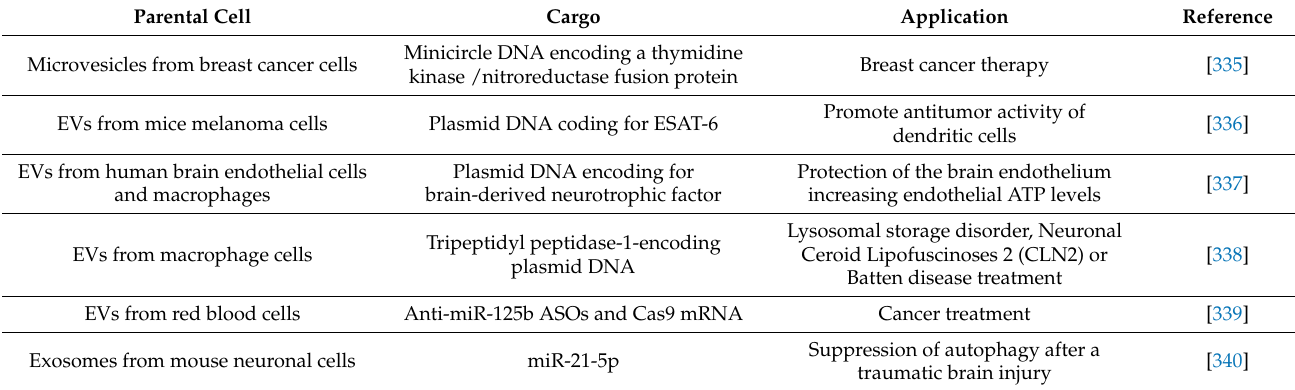
Table 11. Extracellular vesicles’ nucleic acids delivery